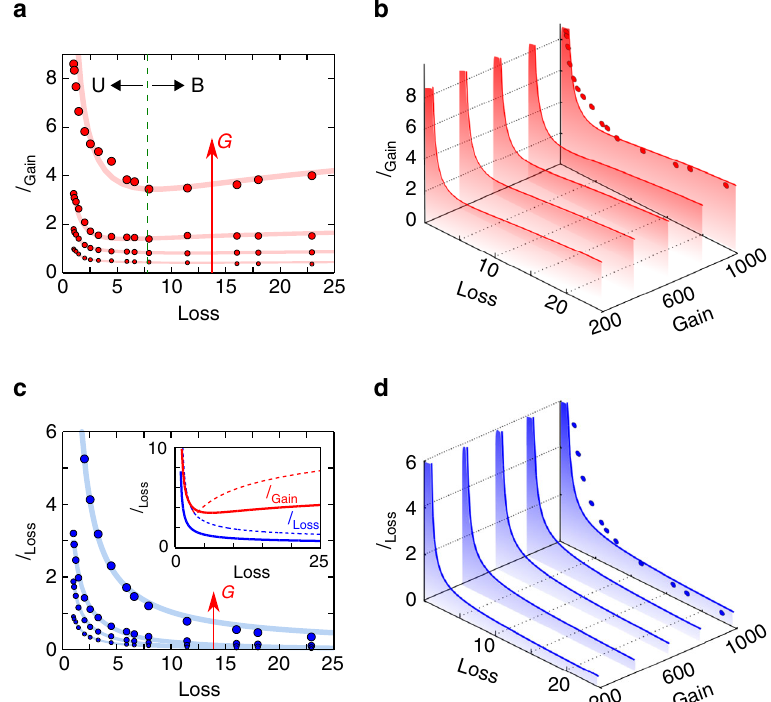
Fig. 5 Lasing characteristics of a statistical PT-symmetric cavity around the exceptional point. a , Measured values of the output power from the gain port I Gain (red circles) while varying the attenuation L at different gain values G (30, 25, 20 and 15 dB). The solid curves are best fi ts to guide the eye, with fi ttings obtained from Eqs 2 – 3 by a suitable choice of coupling κ and detuning Δ . As the loss is gradually increased at fi xed gain, I Gain is non-monotonic. First I Gain decreases with L and goes through a minimum at the exceptional point (indicated by the vertical dashed line), and then increases with loss as the gain and loss sub-cavities decouple. b , Simulations for I Gain while varying the attenuation L at different values of G using Eqs 2 – 3, based on experimental parameters. The red circles correspond to the data in the top-most graph in a for G = 30 dB. The area under the curves are shaded to highlight the gradual increase of the lasing power upon increasing gain. c , Same as a for the power from the loss port I Loss . Inset shows theoretical plots of I Gain and I Loss at G = 30 dB for the statistical PT-symmetric con fi guration of our experiment (solid curves) and the ideal deterministic con fi guration (dashed curve, Δ = 0) highlighting the bifurcation in output power as a consequence of PT-symmetry breaking upon passing through the exceptional point of the system. d , Same as b for I Loss instead of I